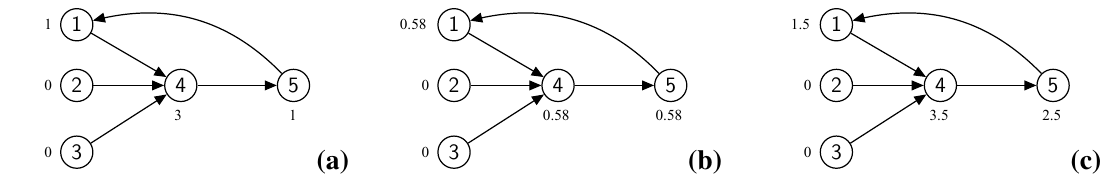
Figure 2. Differences between the three candidate centrality measures. Thecentralities for each measure are indicated next to each node.( a ) In‑degree centrality . Here, only directinfluence is measured. Individual 4 is most influential, as shespread information to three different individuals. Individuals 1,and 5 with one follower each, have still equal importance.( b ) Eigenvector centrality . Since individuals 2 and3 have no followers, they are attributed zero influence, and thuscontribute nothing to the influence of their leader, individual 4.In turn, 1, 4, and 5, each have one follower of non-zero importance,hence they have the same eigenvector scores. ( c ) Second‑ degree centrality with α = 0.5. Individual 4 hasa higher centrality than her in-degree score, as we account for theindirect contribution of individual 1 ( 3 + 0.5 × 1 = 3.5 ) . However, 5 is now more important than 1, because 4 contributes to 5indirectly ( 1 + 0.5 × 3 = 2.5 )